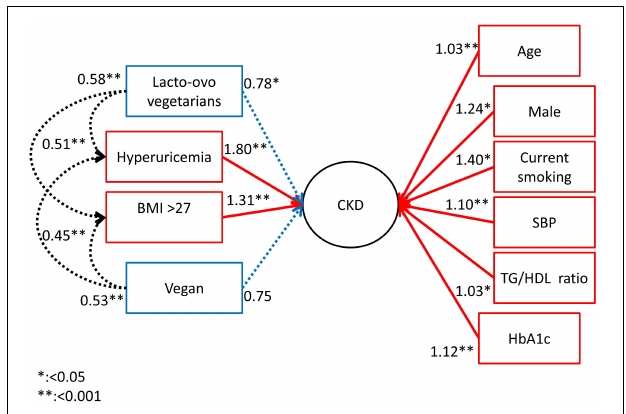
FIGURE 2 | The odds ratio of risk factors on CKD in SEM